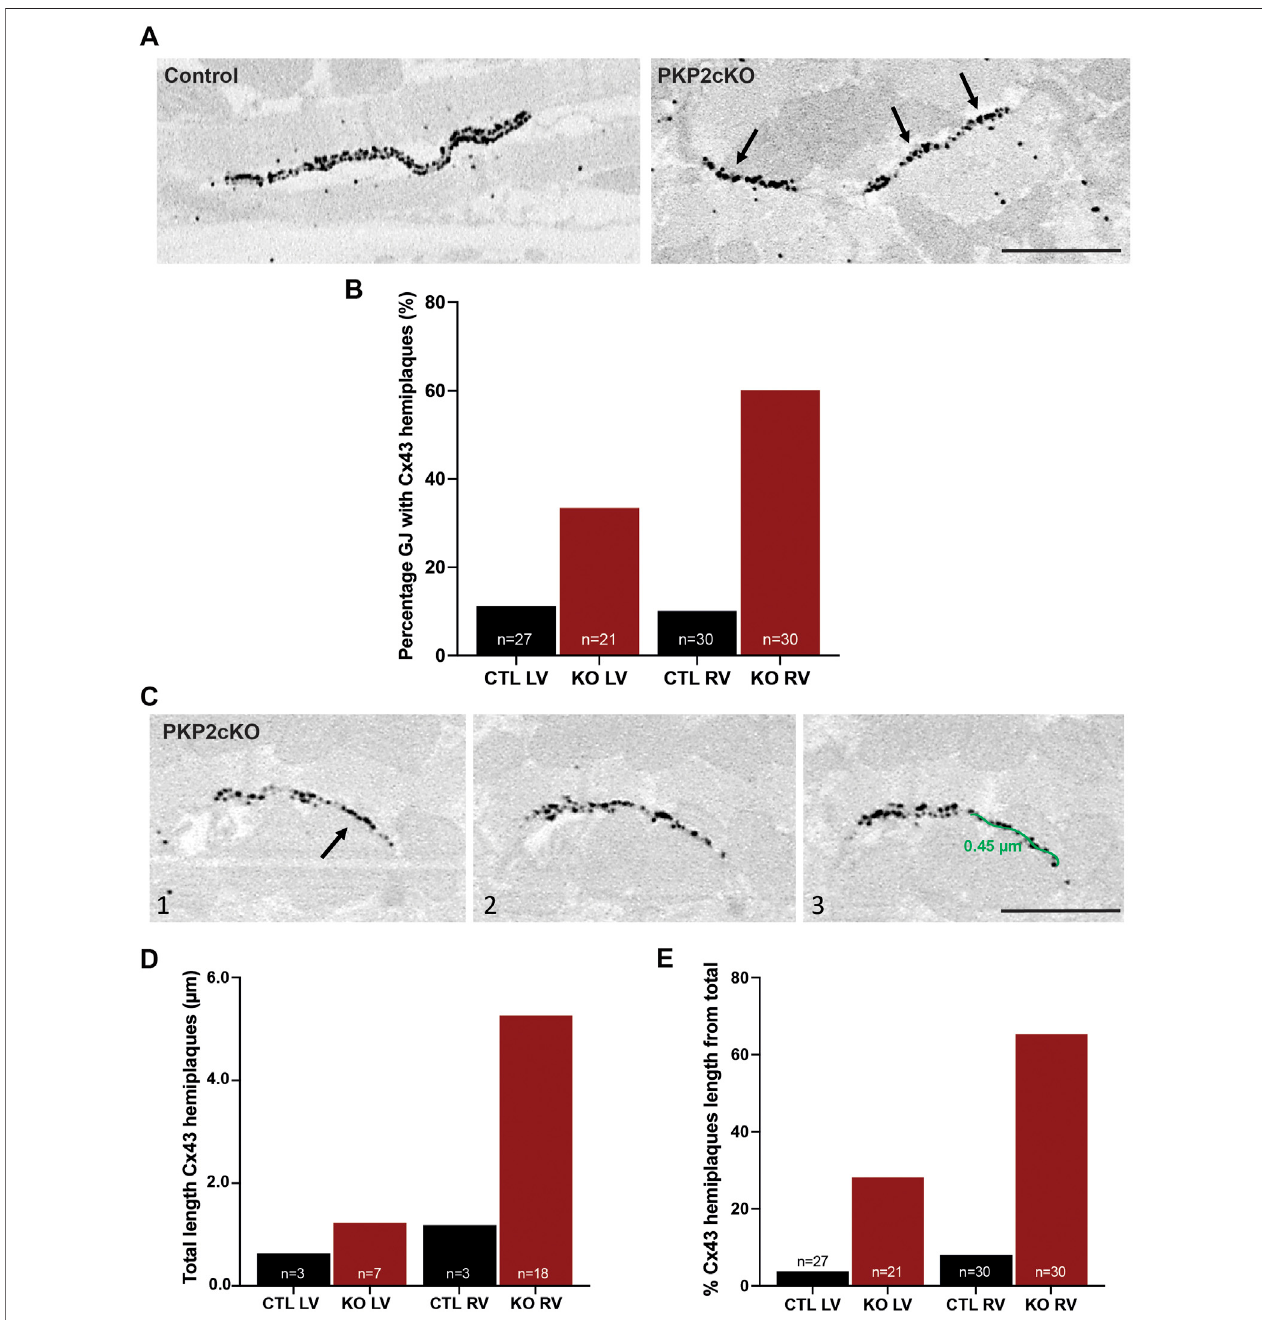
FIGURE5| Connexin43hemiplaquesinadultheartsofPlakophilin-2conditional knockoutmice(PKP2cKO). (A) Representativeexamplesofgapjunctionplaques in control and PKP2cKO hearts, emphasizing in the right panel Connexin43 (Cx43) hemiplaques in a PKP2cKO ventricular sample. Arrowheads point out Cx43 hemiplaques. Scale bar: 0.5 µm. (B) Quanti fi cation of the percentage of gap junction plaques containing Cx43 hemiplaques in control and PKP2cKO hearts, left ventricular(LV) and right ventricular (RV) samplesseparately.Datapresented aspercentage oftotal pool. Control LV; n =27, PKP2cKO LV; n =21, Control RV; n = 30, PKP2cKO RV; n = 30. (C) Representative examples of 3D Cx43 Immuno-Electron Microscopy images of a PKP2cKO heart presenting a Cx43 hemiplaque. The various frames (1 – 3) correspond to different section levels of the same samples. Arrowheads point out Cx43 hemiplaques. Scale bar: 0.5 µm. (D) Quanti fi cation of the total length of Connexin43 hemiplaques in control and PKP2cKO hearts, LV and RV samples separately. Data presented as total length of total pool. Control LV; n = 3, PKP2cKO LV; n = 7, Control RV; n = 3, PKP2cKO RV; n = 18. (E) Quanti fi cation length of Connexin43 hemiplaques in control and PKP2cKO hearts, corrected for the total length of the gap junction plaque. LV and RV samples are quanti fi ed separately. Data presented as percentage of total length per group. Control LV; n = 27, PKP2cKO LV; n = 21, Control RV; n = 30, PKP2cKO RV; n = 30.